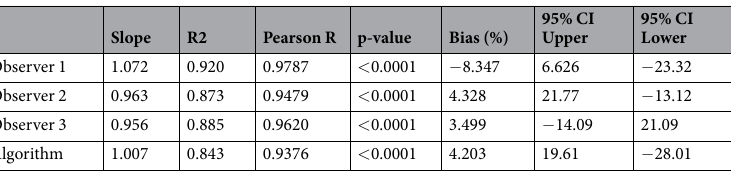
Table 1. Correlation analysis of automated detection versus manual counting of Iba-1 immunopositive